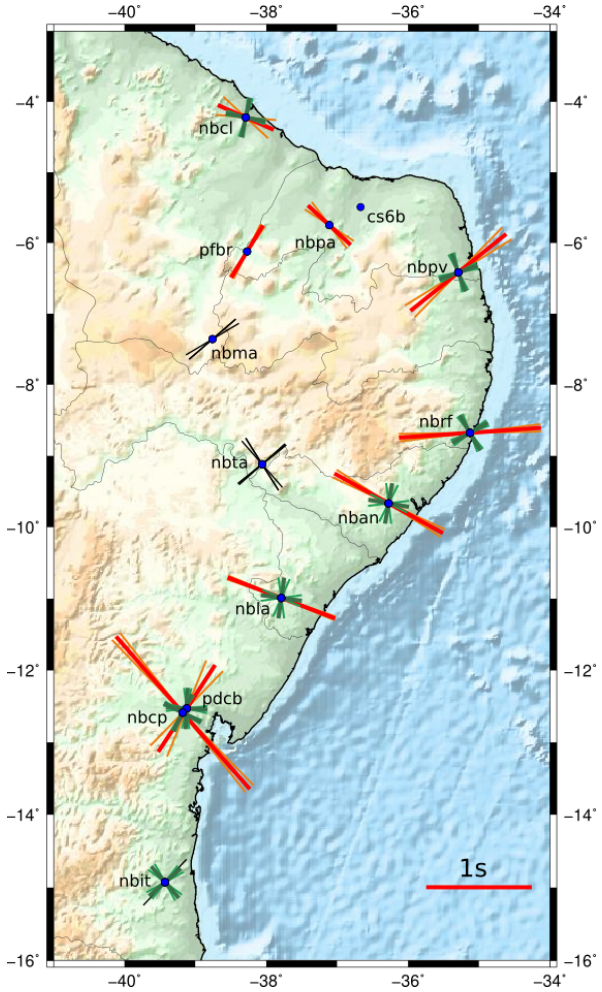
Figure 7. Comparison between fast axis of symmetry recorded by SKS waves (red lines) and k = 2 harmonics (green lines). SKS- splitting results are from Bastow et al. (2011) and Assumpção et al. (2011). Red lines refer to mean fast-axis orientation (line direction) and delay time (line size) beneath the station. When SKS mea- surements provide only null measurements, we display black lines which are in the direction of the back azimuth of the recorded